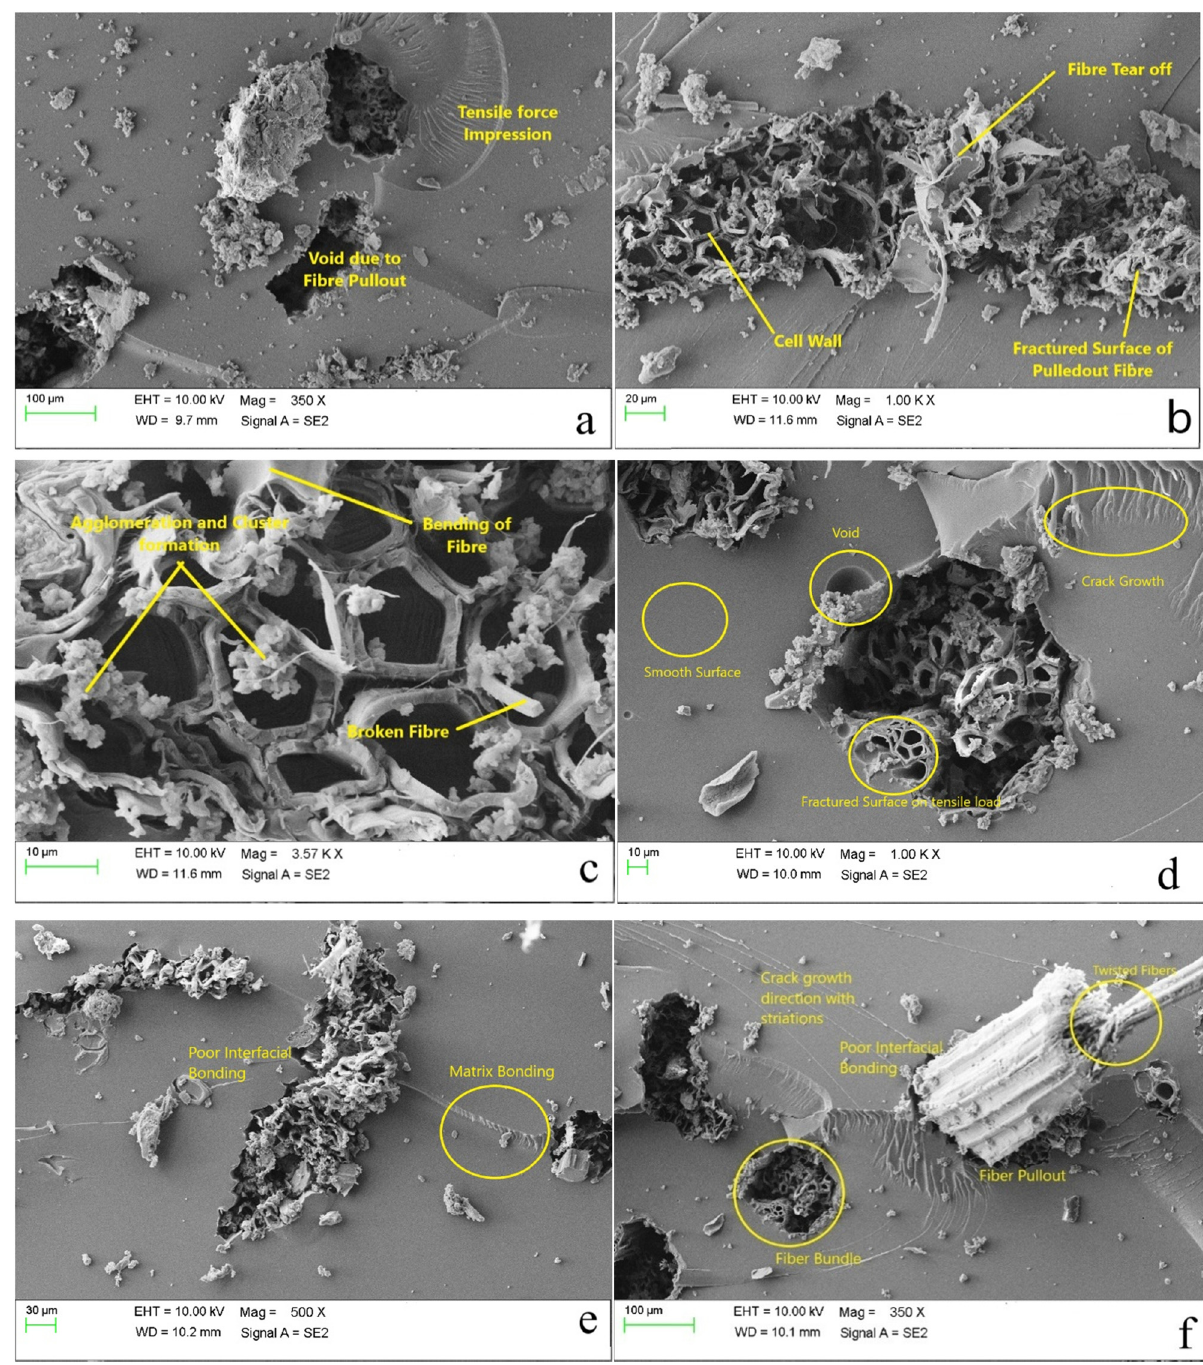
Figure 6: SEM images of fractured surfaces of PALF composite subjected to: ( a ) tensile loading, ( b ) compressive loading, ( c ) fl exural loading and sisal fi ber composite subjected to: ( d ) tensile loading, ( e ) compressive loading, and ( f ) fl exural